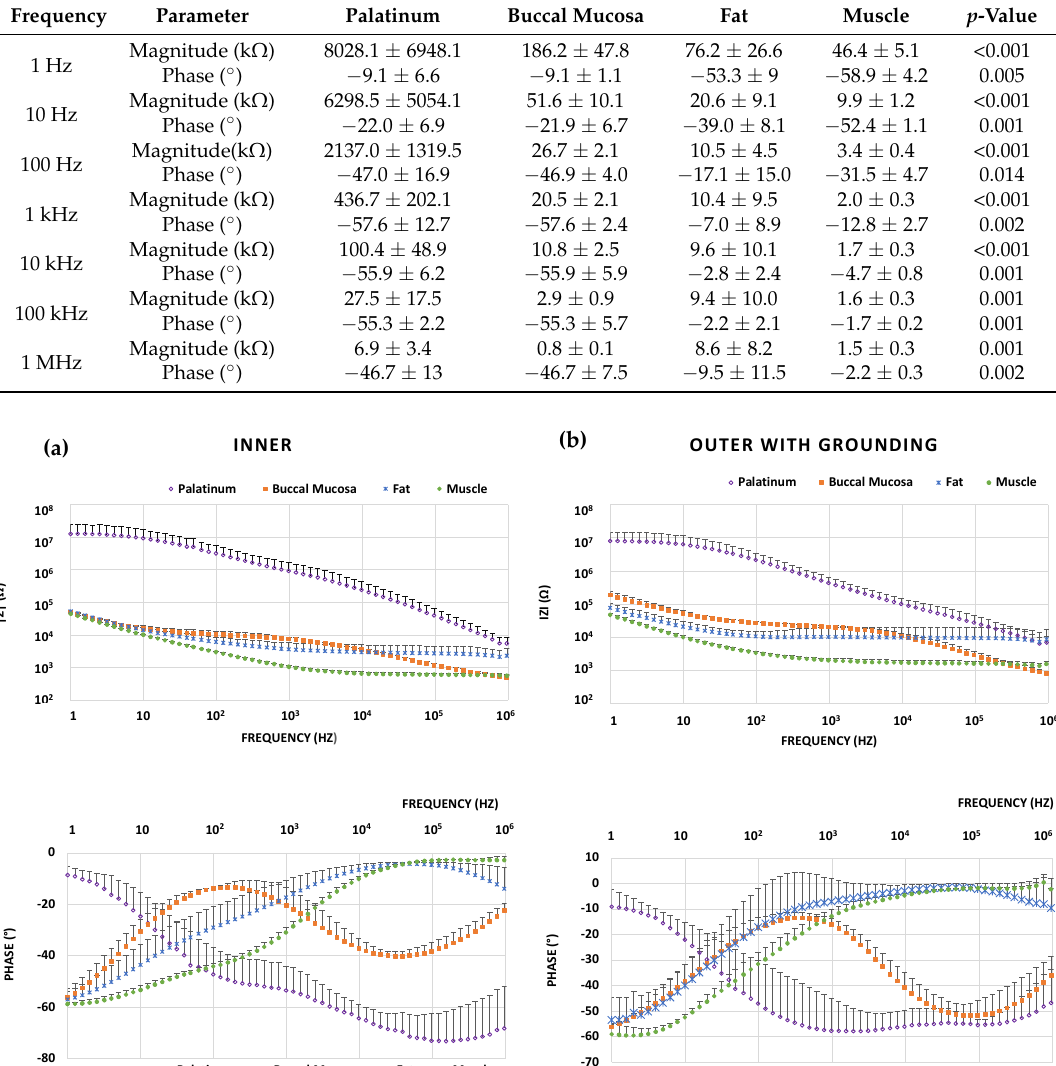
Table 1. Impedance magnitude and phase values (mean ± stdv) for each tissue type at seven discrete frequencies using the inner configuration. The p ‐value was calculated using the Kruskal‐Wallis test.